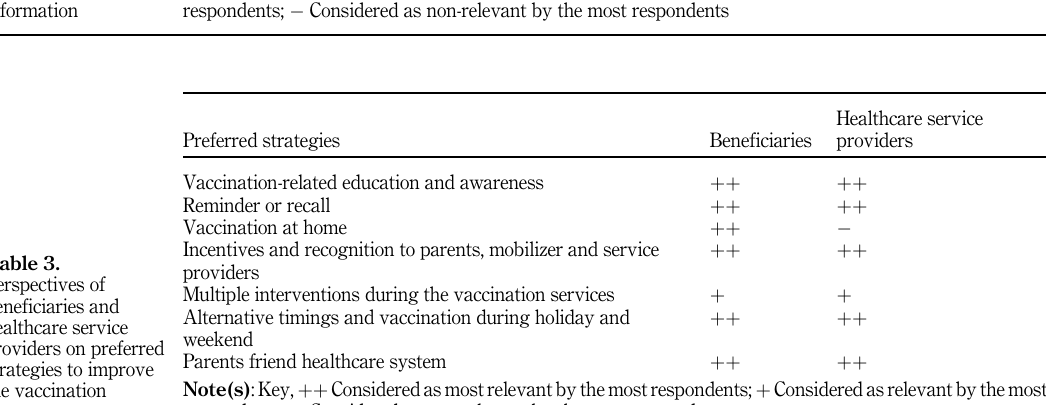
beneficiaries and healthcare service providers on preferences for source of vaccination-related information